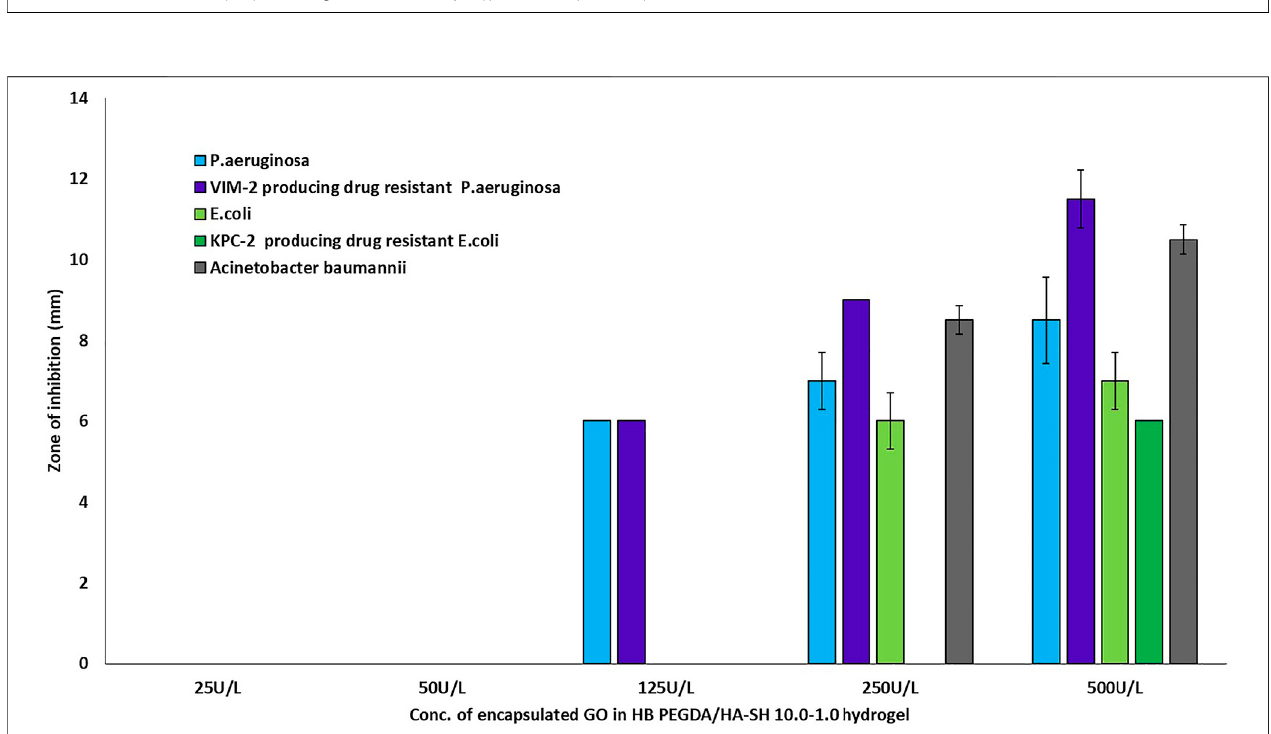
FIGURE 8 | Antibacterial activity of in situ H 2 O 2 -releasing HB PEGDA/HA-SH 10 – 1.0 hydrogels containing different GO activities (25 – 500 U/L) at constant G amount of 2.5 wt% against gram-negative bacteria P. aeruginosa , E. coli , and A. baumanii , and two highly antibiotic-resistant clinical isolates VIM-2-producing drug -resistant Pseudomonas aeruginosa and KPC-2-producing drug-resistant Escherichia coli . The graph shows the measured inhibition zones (ZOI) of the agar diffusion assays.